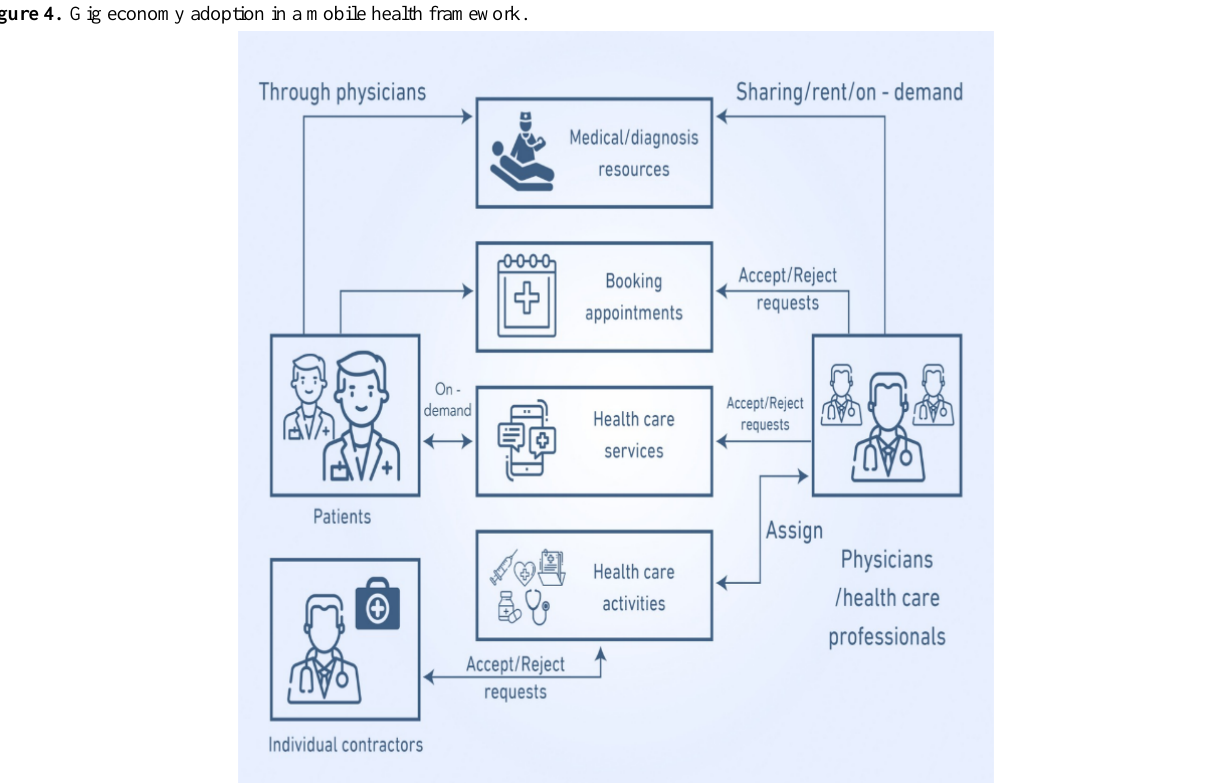
Figure 4. Gig economy adoption in a mobile health